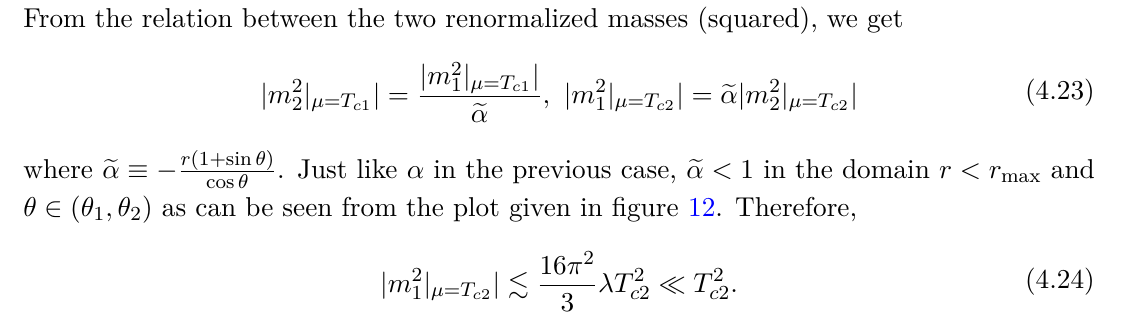
and θ ∈ ( θ ) max 1 , θ 2